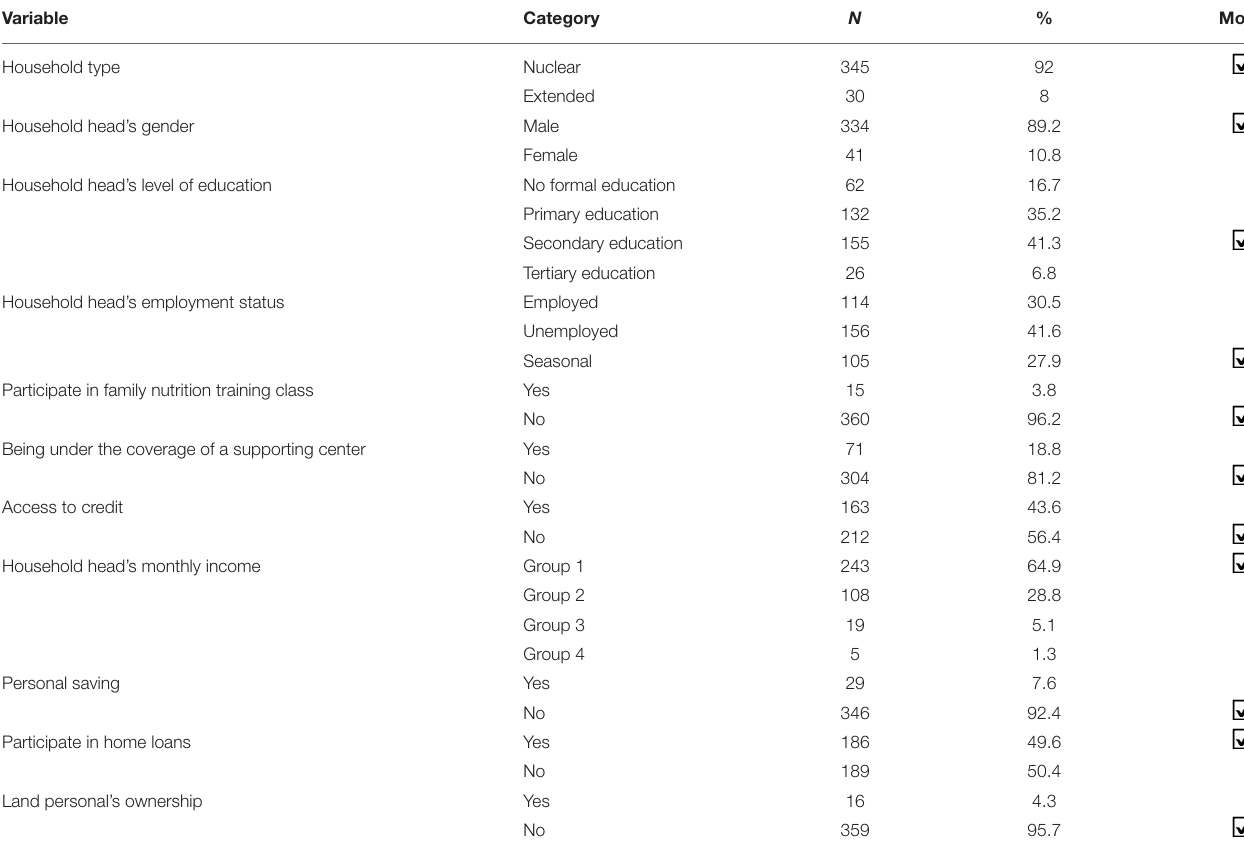
TABLE 4 | Descriptive statistics of discrete